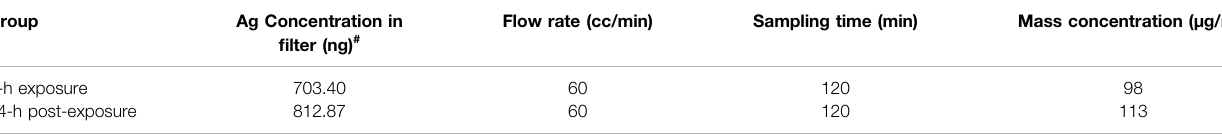
TABLE 4 | Mass concentration of AgNP aerosol sampled during 2-h exposure. Group